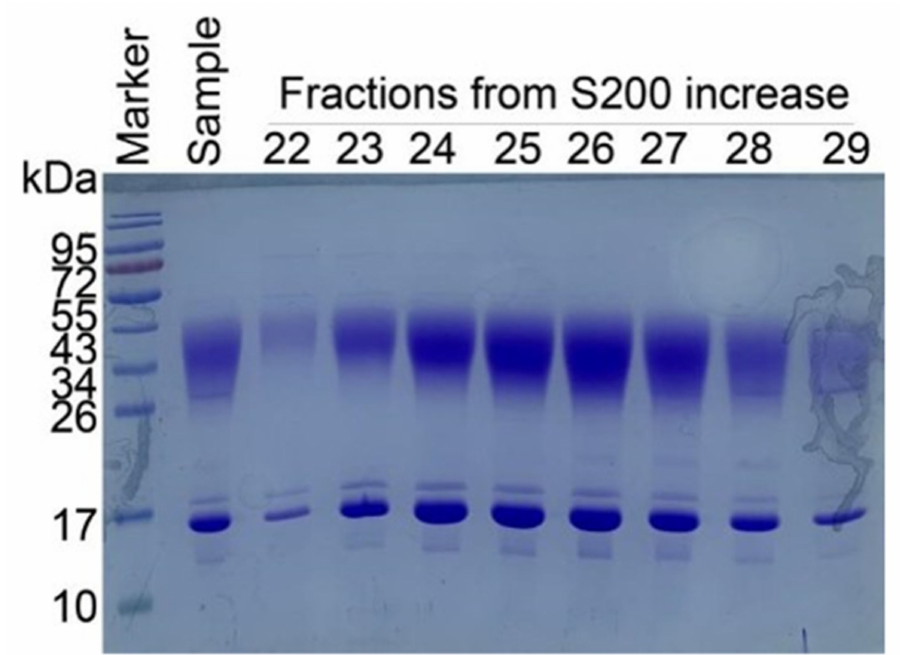
Figure 3. IMM01-Fab and CD47-His were mixed in molar ratio 1:1 and incubated at 4 ◦ C overnight. The size-exclusion chromatography (SEC) method was used for IMM01-Fab/CD47 complex purifi- cation. Superdex200 column was used to increase purity of IMM01-Fab/CD47 complex. Fractions 23–26 were concentrated for